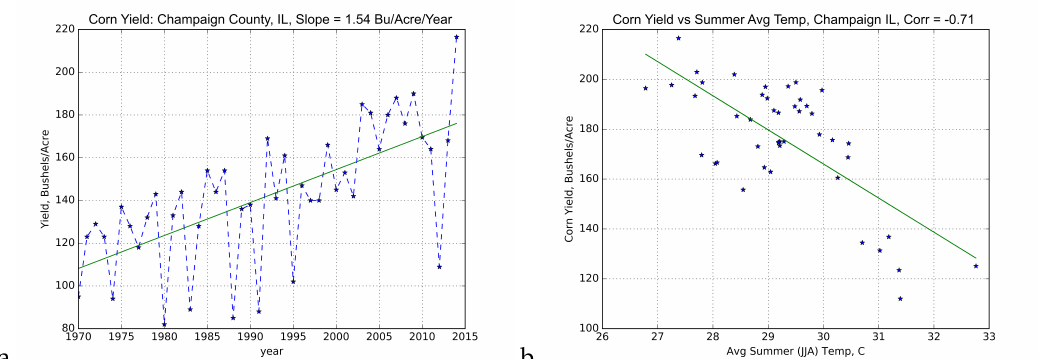
Figure 1. The corn yield over time for an example county ( a ) and detrended corn yield plotted against summer average temperature ( b ). The correlation of − 0.71 is highly significant. Data is from the USDA